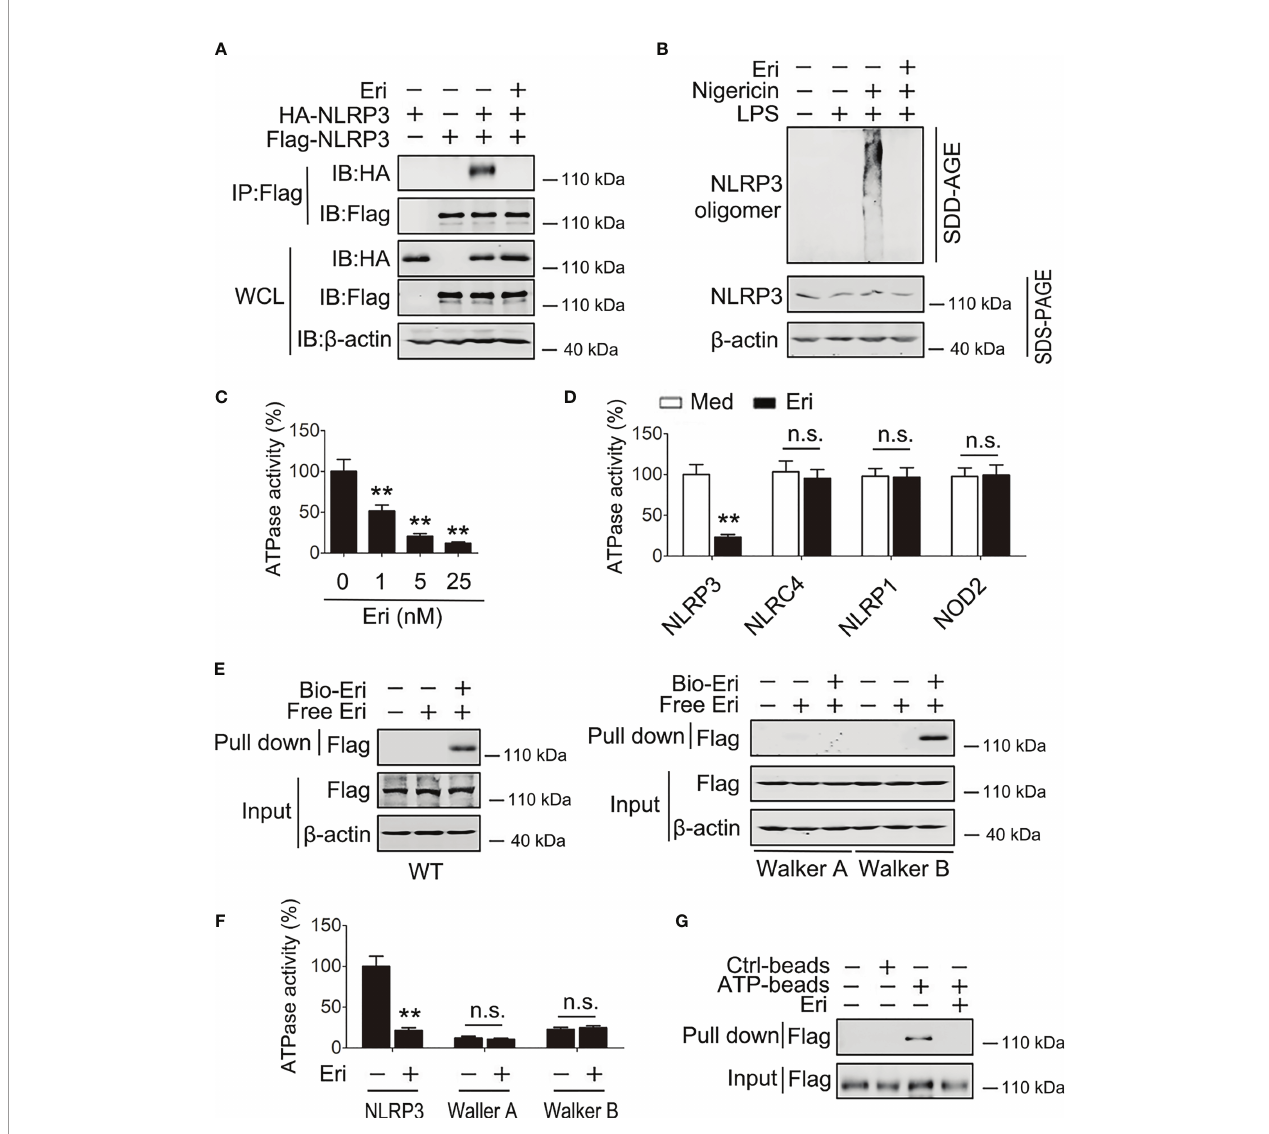
FIGURE 5 | Eri suppresses the ATPase activity of NLRP3. (A) HEK293T cells were transfected with indicated plasmids for 36 h. Immunoblot analysis of binding complexes isolated from BMDMs extracts incubated with Bio-Eri. (B) BMDMs were treated with LPS (1 µg/ml for 6 h) or Eri (5 nM for 6 h). Cells extracts were analyzed using SDD-AGE (upper panel) and SDS-PAGE (lower panel). (C) ATPase activity assay for puri fi ed NLRP3 in the presence of different dose of Eri. (D) ATPase activity assay for puri fi ed NLRP3, NLRC4, NLRP1 and NOD2 with or without presence of Eri (5 nM). (E) HEK293T cells were transfected with Flag- NLRP3 (left panel) or NLRP3 constructs with Walker A or Walker B motif mutation (right panel) for 36 h. Immunoblot analysis of binding complexes isolated from cells extracts incubated with Bio-Eri or free Eri. (F) ATP-binding assay for puri fi ed Flag-NLRP3 in the presence of Eri (5 nM). (G) ATPase activity assay for puri fi ed Flag- NLRP3 or mutants with or without presence of Eri (5 nM). All experiments were repeated at least three times. Bar graphs present means ± SD (**P < 0.01; n.s., not signi fi